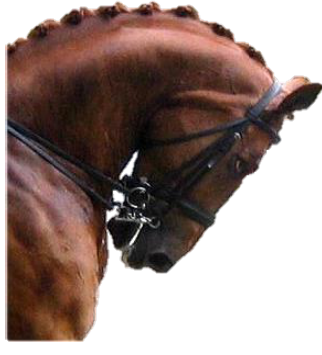
Figure 1. The “Rollkur” posture, also called “Hyperflexion.” The horse’s neck is extremely flexed, until the nose touches the